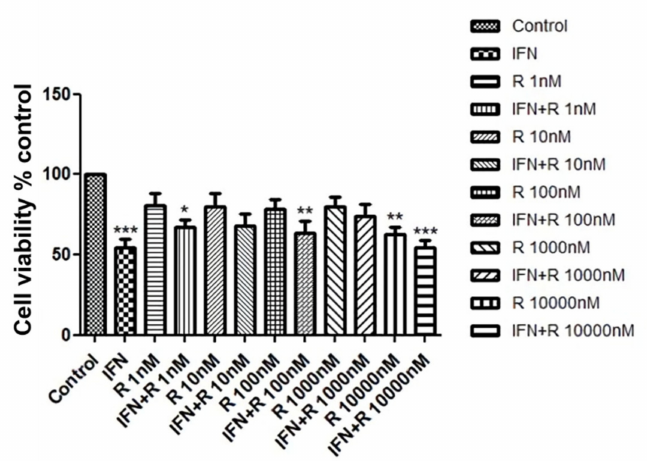
Figure 1. The e ff ects of ruxolitinib treatment on the human dermal papilla cells (hDPCs) viability. Cell viability was not significantly a ff ected by various concentrations of ruxolitinib treatment. The data represent the means ± SEM, n = 4, statistically significant at * p < 0.05, ** p < 0.01, *** p < 0.001, compared with the control.